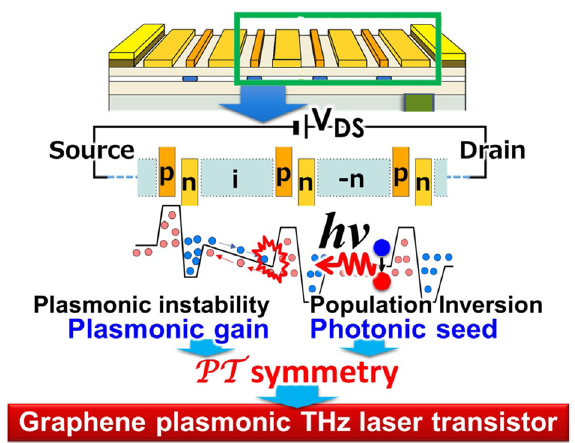
Figure 15: A possible structure for graphene plasmonic THz laser transistor consisting of a series of unit sections including the photonic seed and plasmonic gain